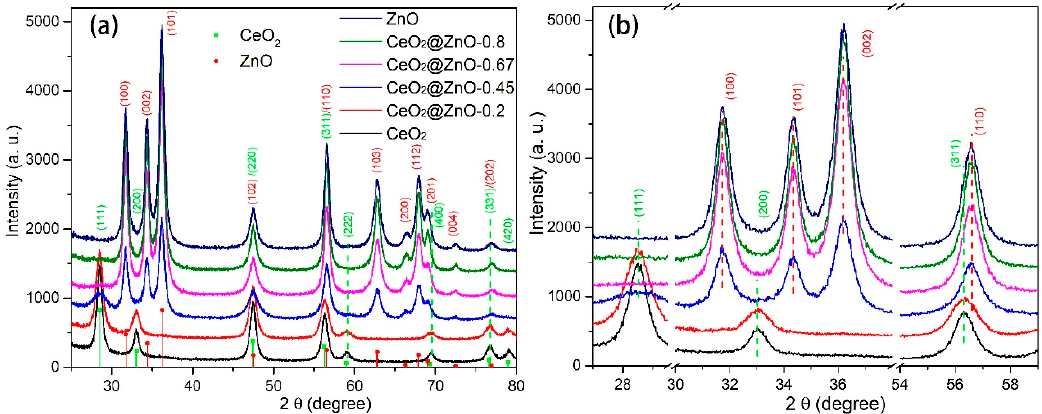
Figure 1. ( a ) XRD patterns for the CeO 2 , ZnO, and CeO 2 @ZnO nanocomposites (predicted peak positions for cubic CeO 2 and hexagonal ZnO are shown on the x -axis) and ( b ) an enlarged figure showing the most intense diffraction peaks in ( a ).